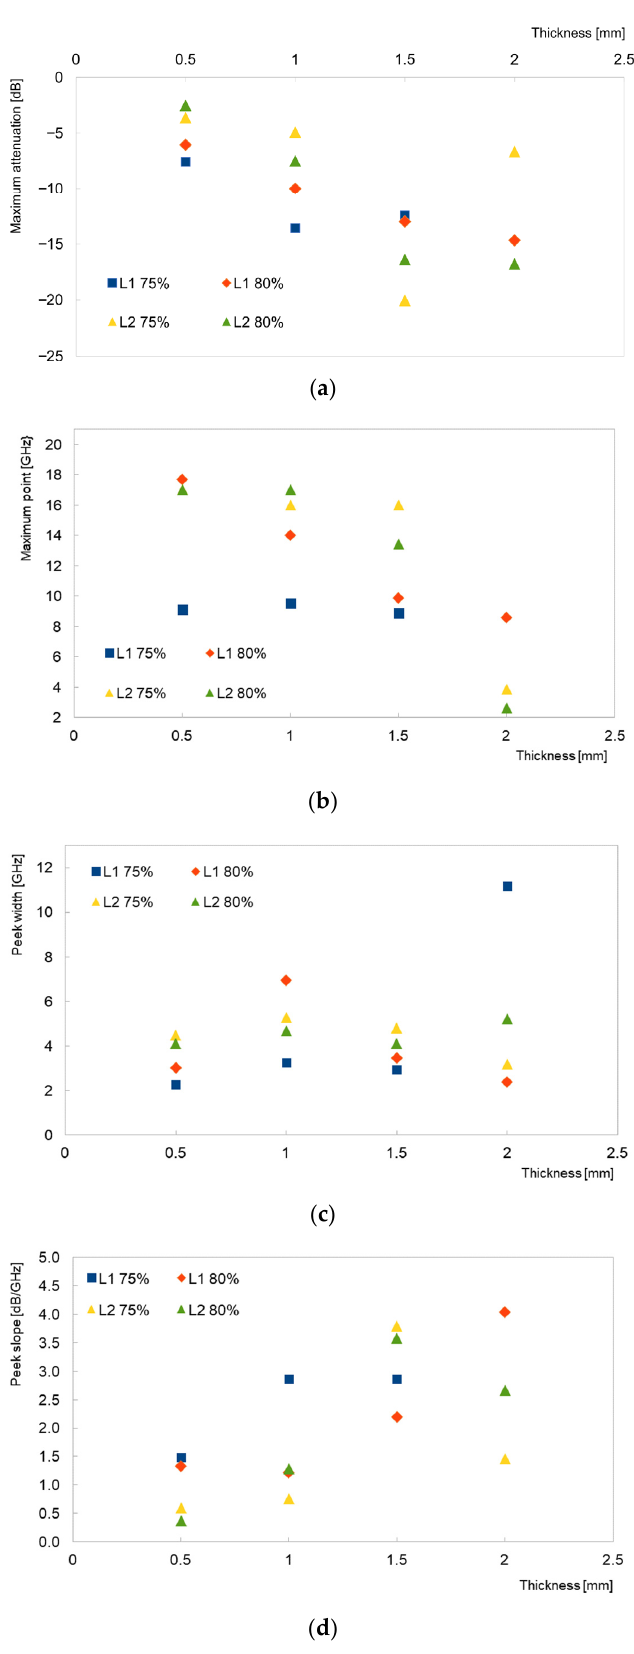
Figure 4. Relationship of layer thickness vs. selected factors: maximum attenuation ( a ); frequency of maximum of attenuation ( b ); signal width ( c ); and curve slope ( d